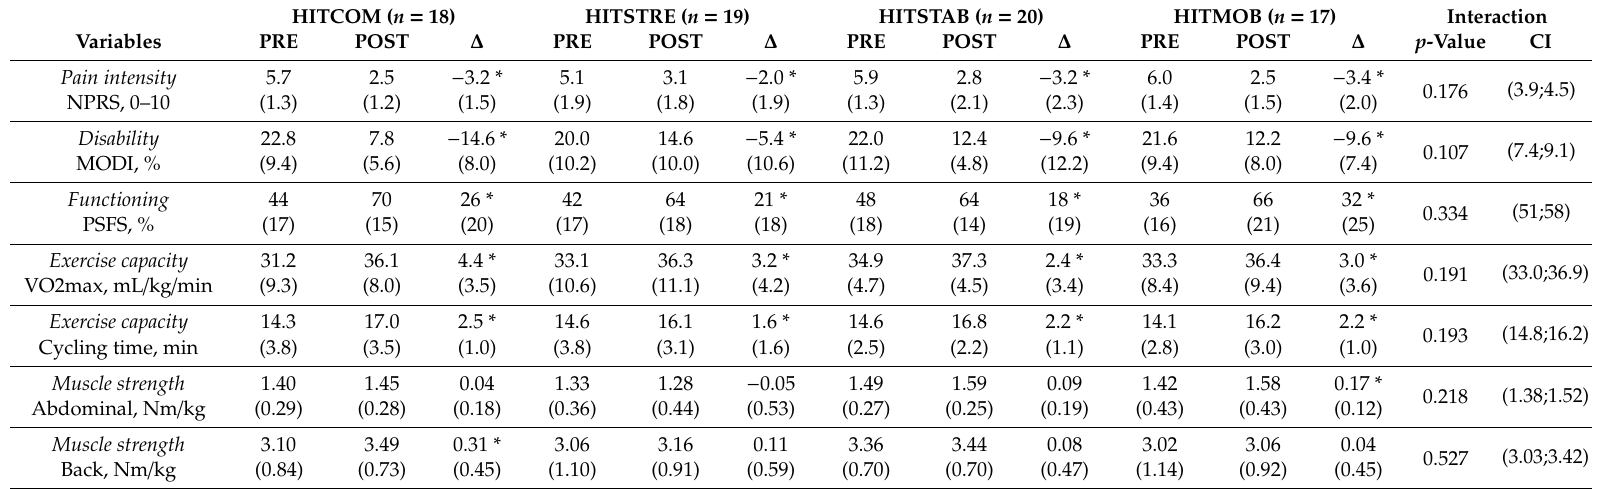
Table 2. Results of the outcome measures collected from participants at PRE and POST, together with between-group di ff